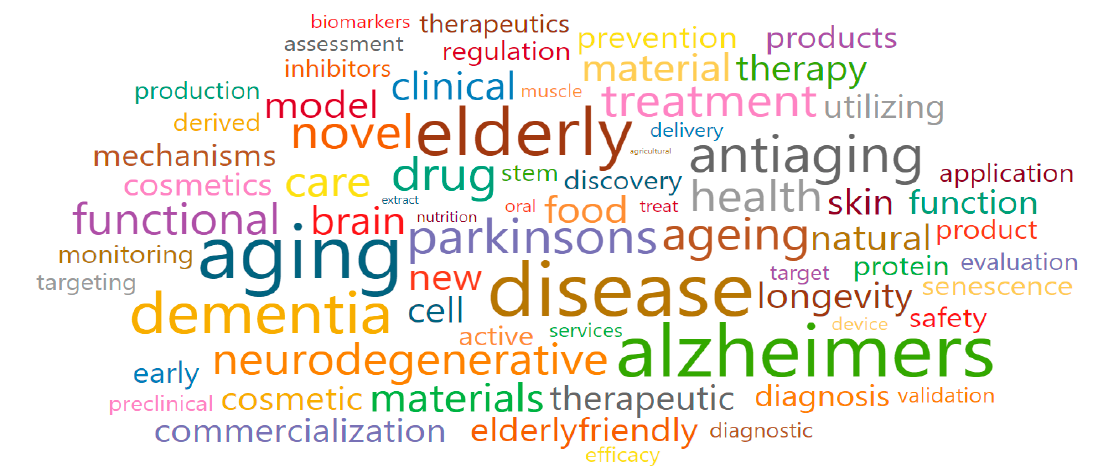
Figure 7. Words cloud in Anti-aging medicine and substances (Cluster 2).